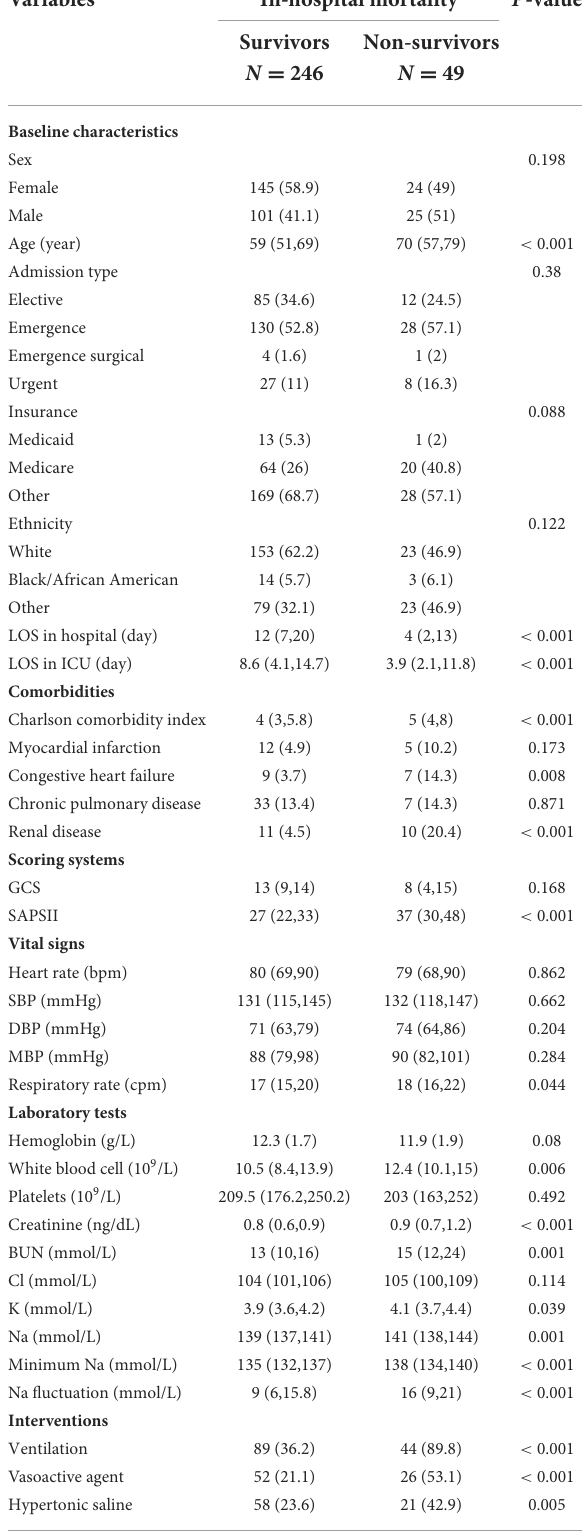
TABLE 1 Baseline characteristics related to in-hospital